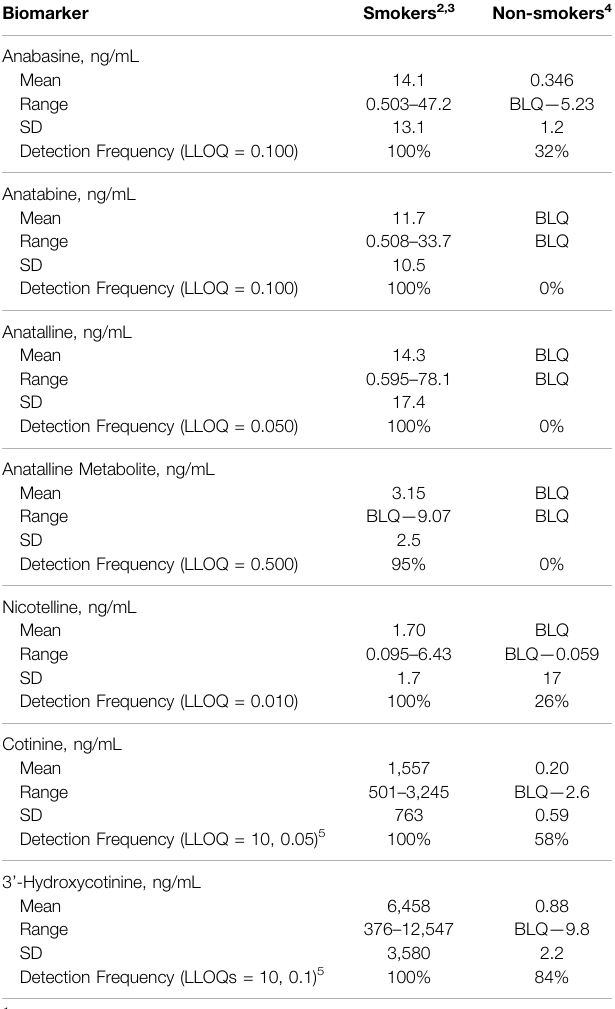
TABLE 5 | Concentrations of biomarkers in urine of 20 cigarette smokers and 19 non-smokers 1